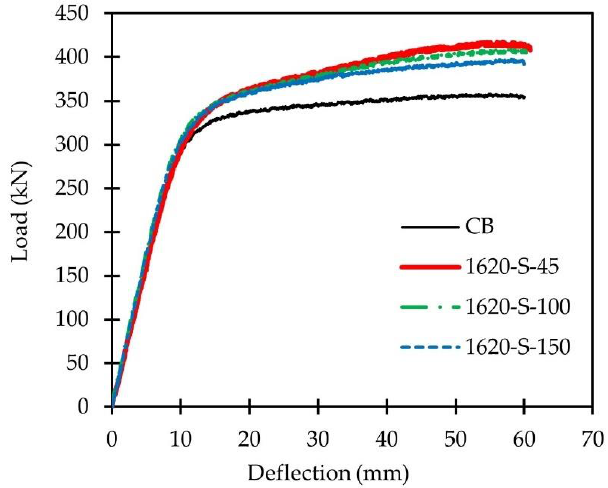
Figure 11. Load – deflection curves of 1620-S-45, 1620-S-100, 1620-S-150 and CB.